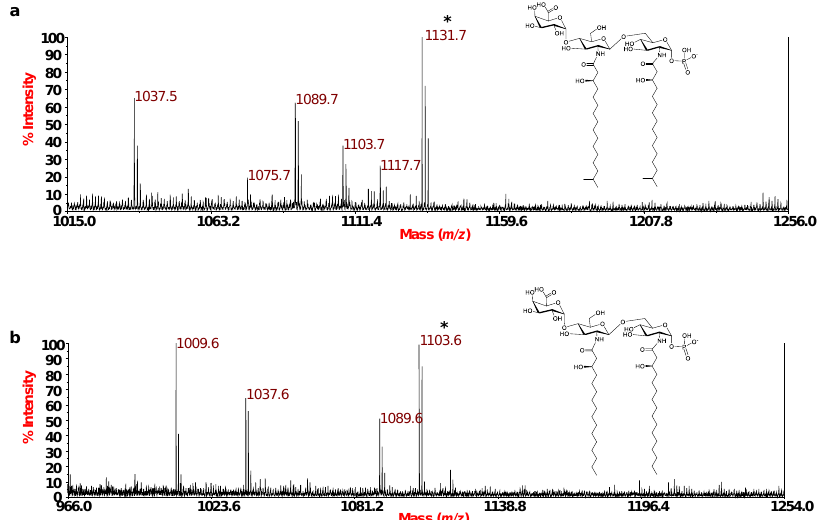
Figure 3. MALDI MS/MS analysis of tetra- ( a ) and tri-acylated ( b ) lipid A species from E. pacifica KMM 6172 T . ( a ) Negative- ion MALDI MS/MS spectrum of precursor ion at m / z 1527.7, another representative ion peak of the cluster assigned to the tetra-acylated lipid A species. ( b ) Negative-ion MALDI MS/MS spectrum of precursor ion at m / z 1371.6, chosen as a representative of the cluster ascribed to the tri-acylated lipid A species. The assignment of the main fragments is indicated in the spectra. The proposed structure for the lipid A species is reported in each inset. The representation of 15:0(3-OH) is tentatively given in its branching form. As both the phosphate group and the HexA unit may hold the charge, the proposed structures have been sketched carrying two negative charges for information purposes only. Peaks originating from the loss of C 15 H 30 O (226 mass units) have been also indicated.